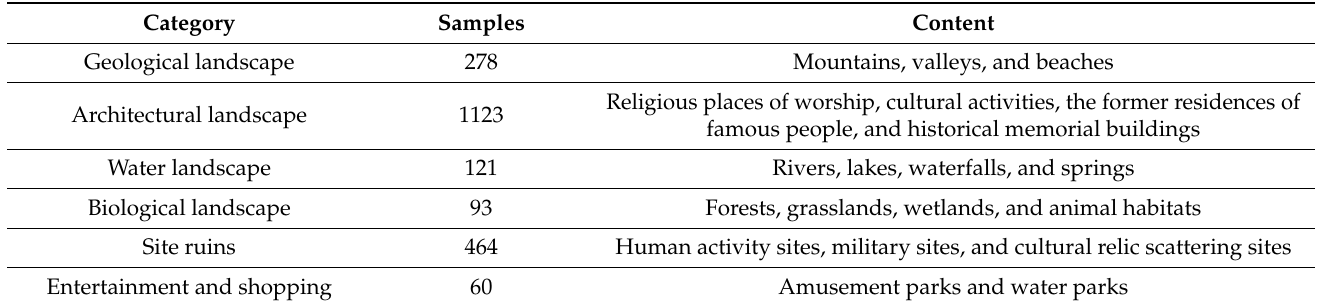
Table 1. POI number and classification of tourism resources in